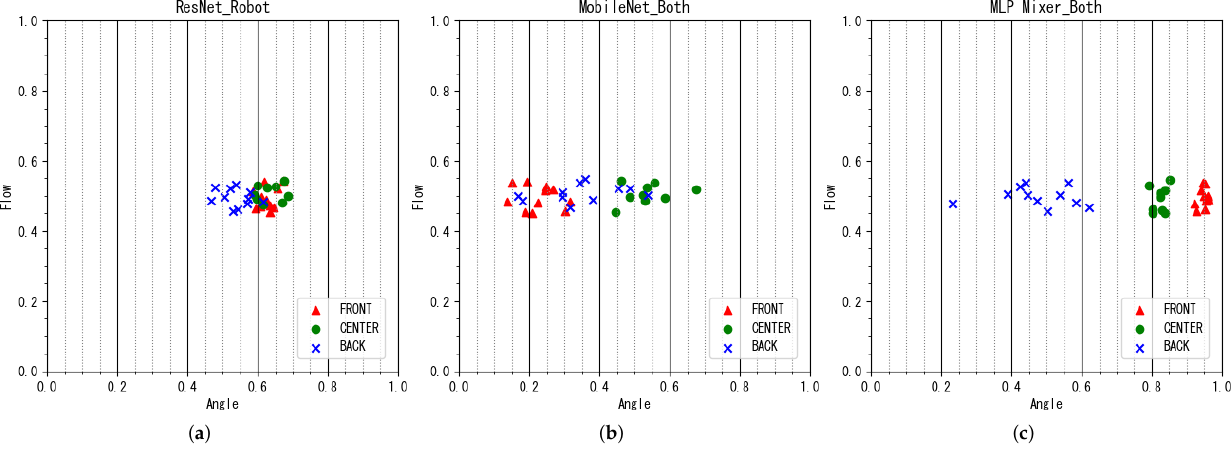
Figure 10. Example of angle estimation results. ( a ) MobileNet and human dataset (conventional method). ( b ) MLP-Mixer and robot dataset (proposed method). ( c ) MLP-Mixer and robot + human datasets (proposed